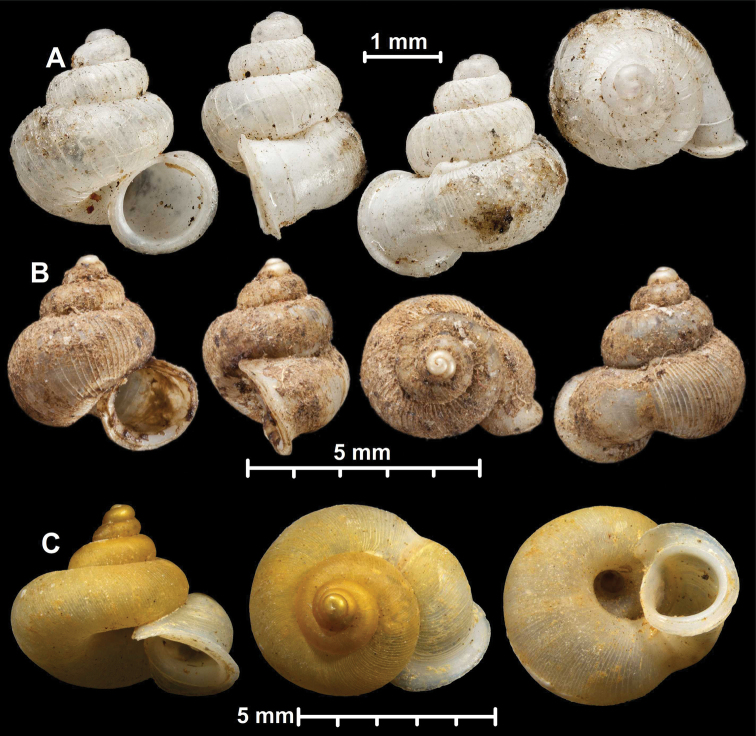
Type species of alycaeid genus-group taxa APincerna
constricta (Benson, 1851), syntype (NHMUK 1906.4.4.41; type species of Cycloryx) BPincerna
liratula (Preston, 1907), syntype (NHMUK 1907.5.20.191; type species of Pincerna) CStomacosmethis
sarasinorum (Bollinger, 1918), lectotype (NHMB 2411.a; type species of Stomacosmethis). Photographs: Harold Taylor (A, B); Eduard Stoeckli (C).